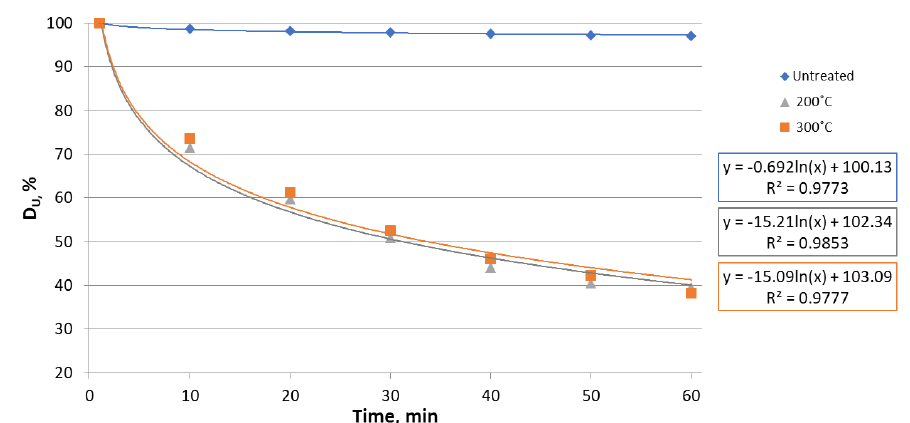
Figure 5. Mechanical durability of untreated and torrefied sunflower husk pellets.